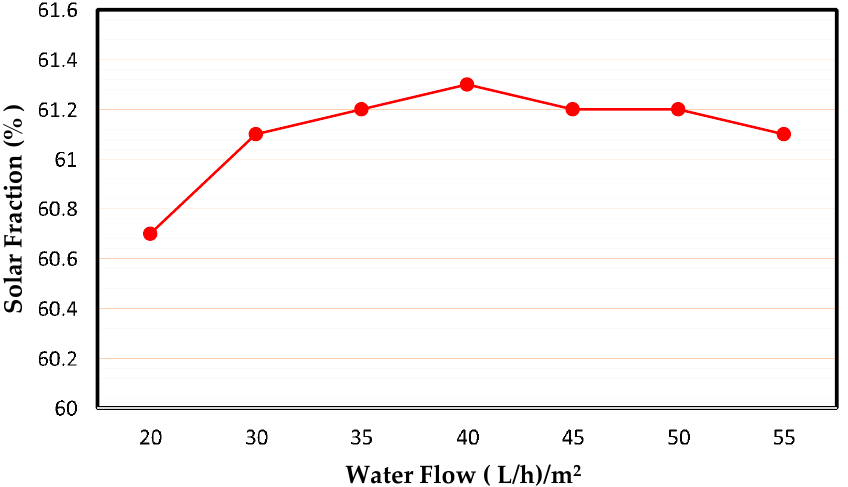
Figure 10. Variation of the solar fraction with the flow of water circulating through the collector.